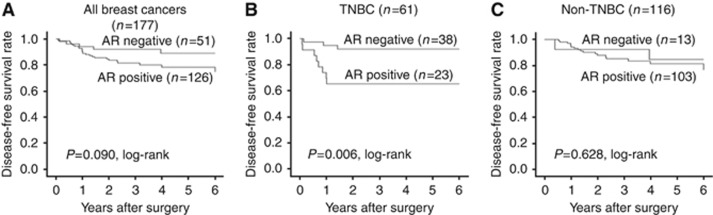
Analysis of all 177 patients treated with neoadjuvant chemotherapy (NAC) revealed no significant difference in disease-free survival (DFS) associated with AR expression (P=0.090, log-rank) (A). No significant difference in DFS according to AR expression was observed in patients with non-TNBC (P=0.628, log-rank) (B). A significantly shortened non-recurrence period was observed in patients with AR-expressing tumours, when the analysis was limited to patients with TNBC (P=0.006, log-rank) (C).